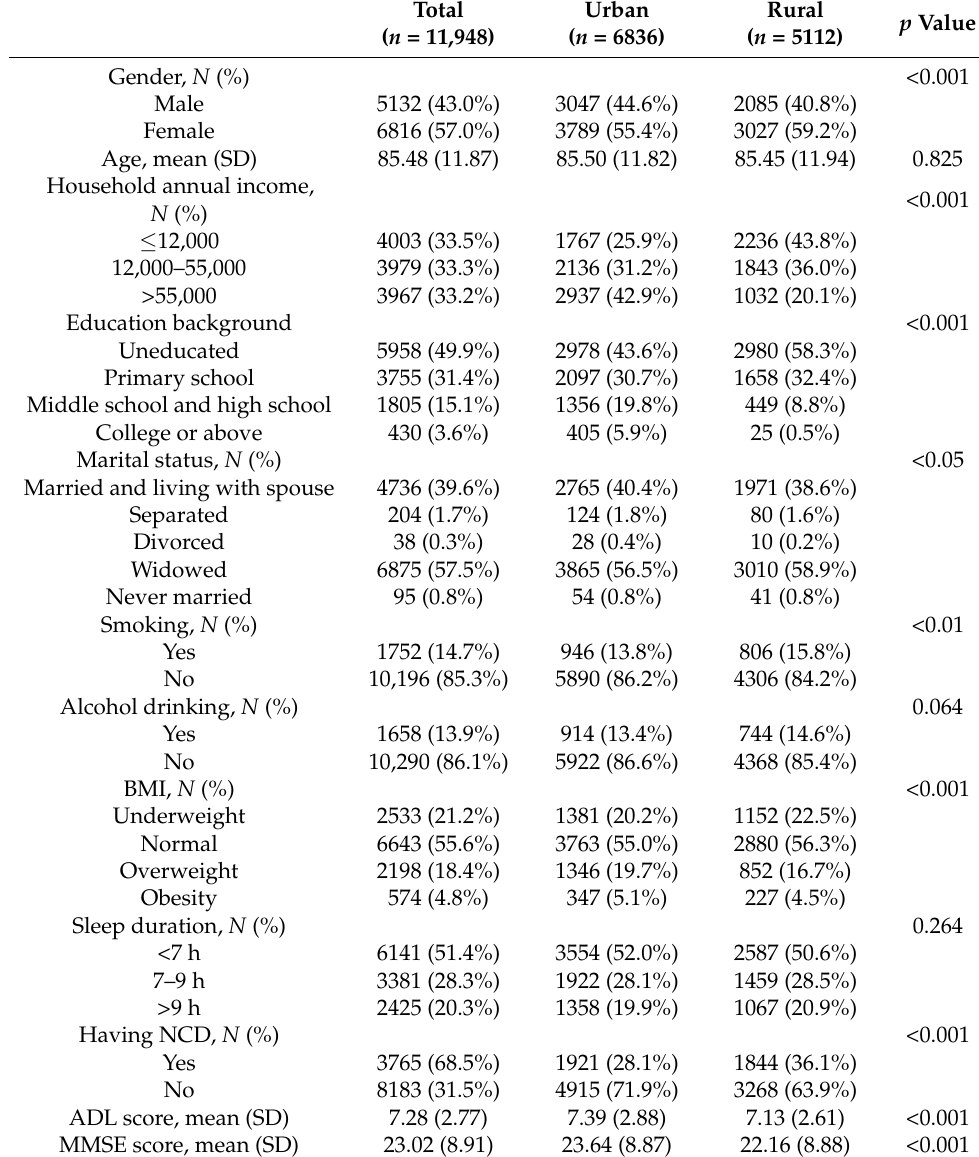
Table 1. Descriptive summary of study